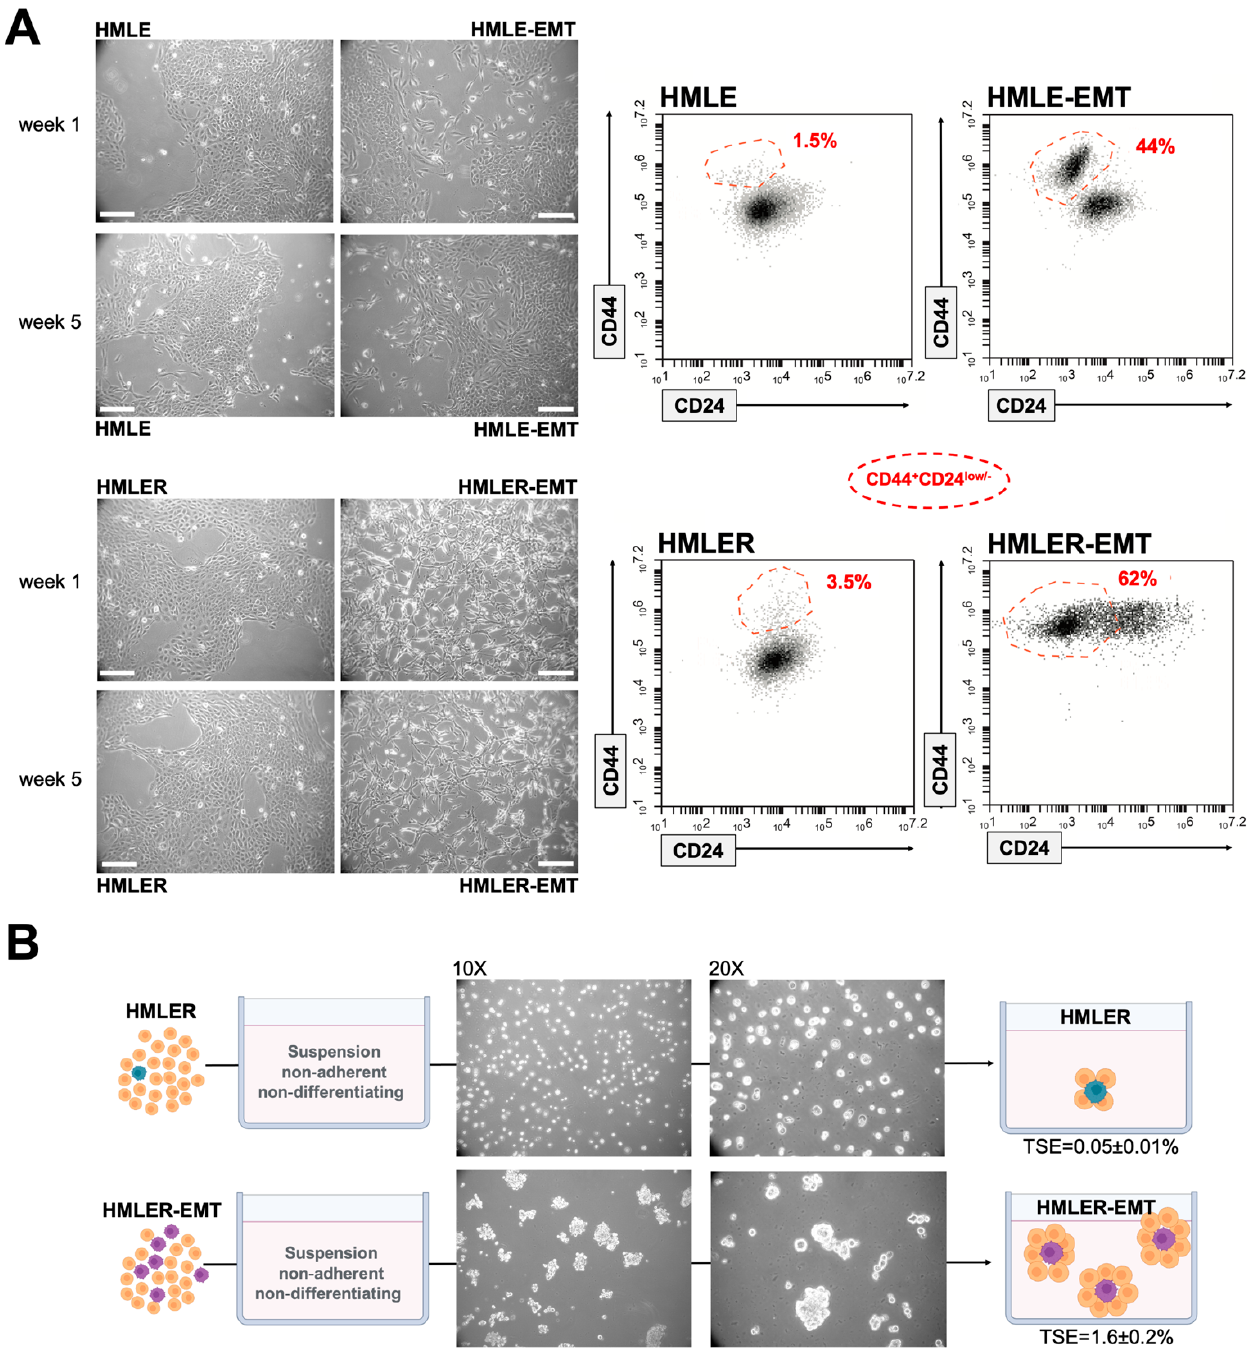
Figure 2. Mesenchymal and tumorigenic traits in HMLE/HMLER cells induced to undergo EMT. ( A ) Left: Representative phase contrast microphotographs of HMLE and HMLER cells modified by shRNA-mediated inhibition of the human CDH1 gene. Scale bar, 100 µ m. Right: Representative flow cytometry plots of CD44 and CD24 expression in HMLE/HMLE-EMT and HMLER/HMLER-EMT pairs ( n = 3). Red dashed line indicates the distribution of the CD44 + CD24 − /low subpopulation; percentage is indicated for each model. ( B ) Representative light microscope microphotographs of tumorspheres formed by HMLER and HMLER-EMT cells growing in sphere medium for 7 days (10X and 20X magnifications). MSFE was calculated as the number of tumorspheres (diameter > 50 µ m) formed in 7 days divided by the original number of cells seeded and expressed as percentage means ± SD ( n = 5 in